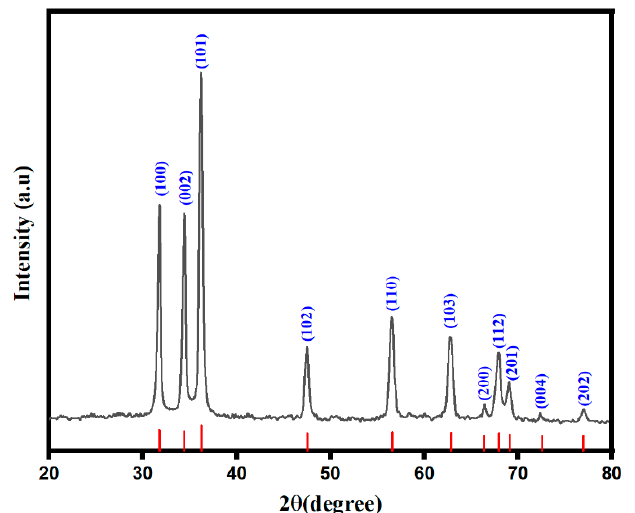
Figure 3. XRD pattern of LP-ZnO NPs.